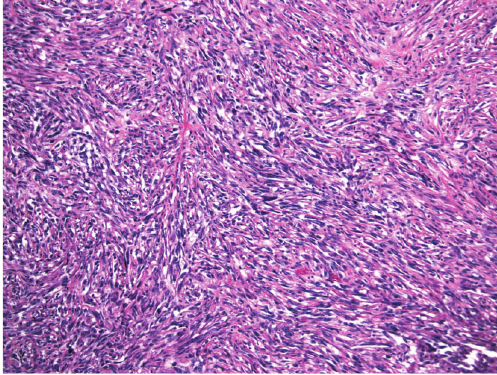
Figure 3: Cellular areas of the dedi ff erentiated component.